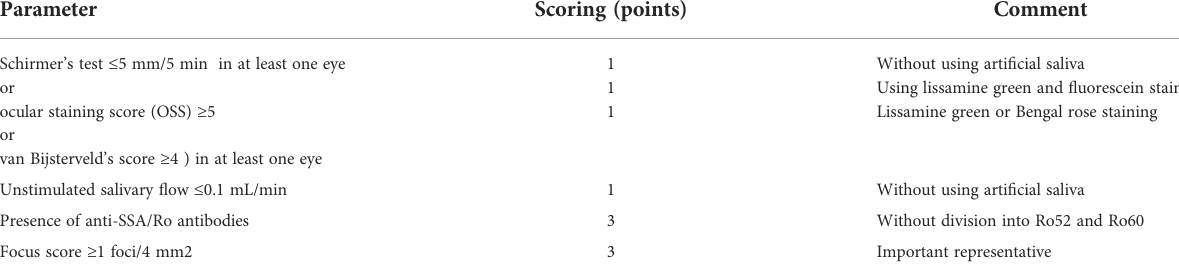
classi fi cation criteria is presented. According to the classi fi cation criteria, pSS diagnosis requires a total score of ≥ 4 points (5,